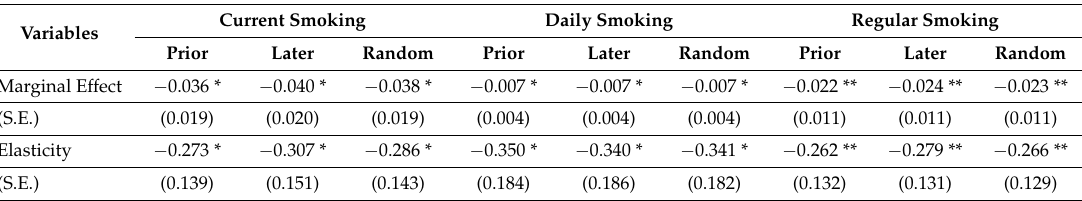
Table 4. Marginal effects and elasticity, the Association between POS ad bans and current smoking, daily smoking, and regular smoking